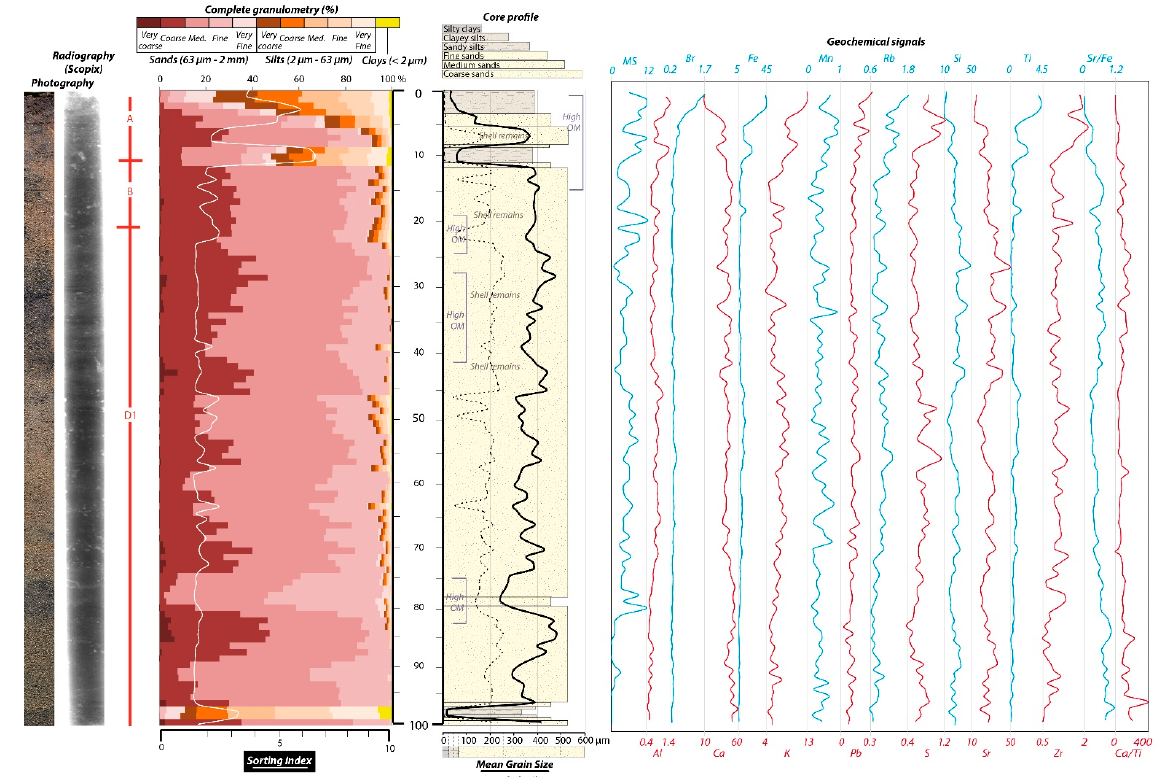
Figure 8. BH-B core log with photography, radiography, grain size results, and geochemical signals.